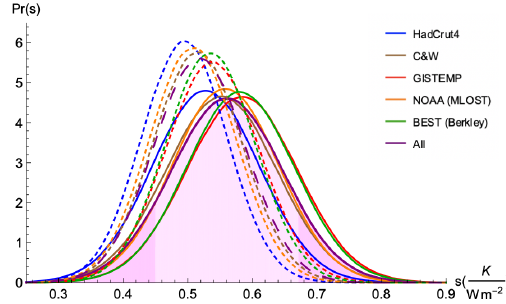
Figure 7. For each observational dataset and their average, PDFs are shown for the climate sensitivity parameter s (the ECS, here in units of K(Wm − 2 ) − 1 ), F Aer (solid) and F Aer RCP SSP